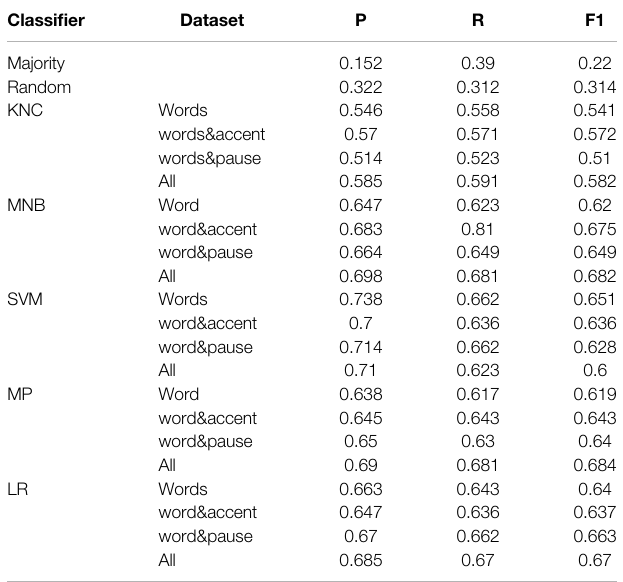
TABLE 5 | Results of classi fi ers predicting pronominal type in the DanPASS dialogues. Classi fi er Dataset